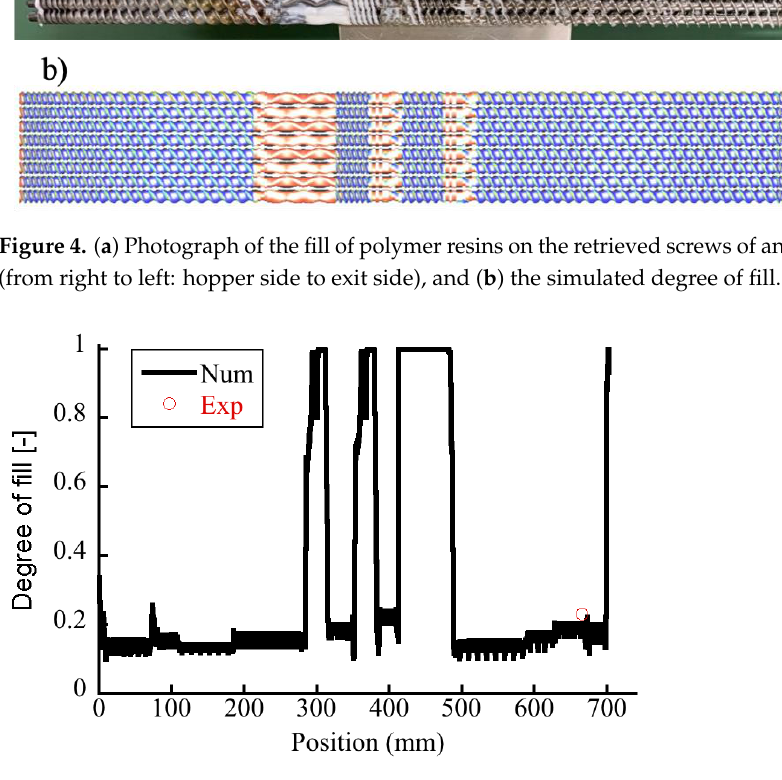
Figure 5. Degree of fill along the screw in the octa-screw